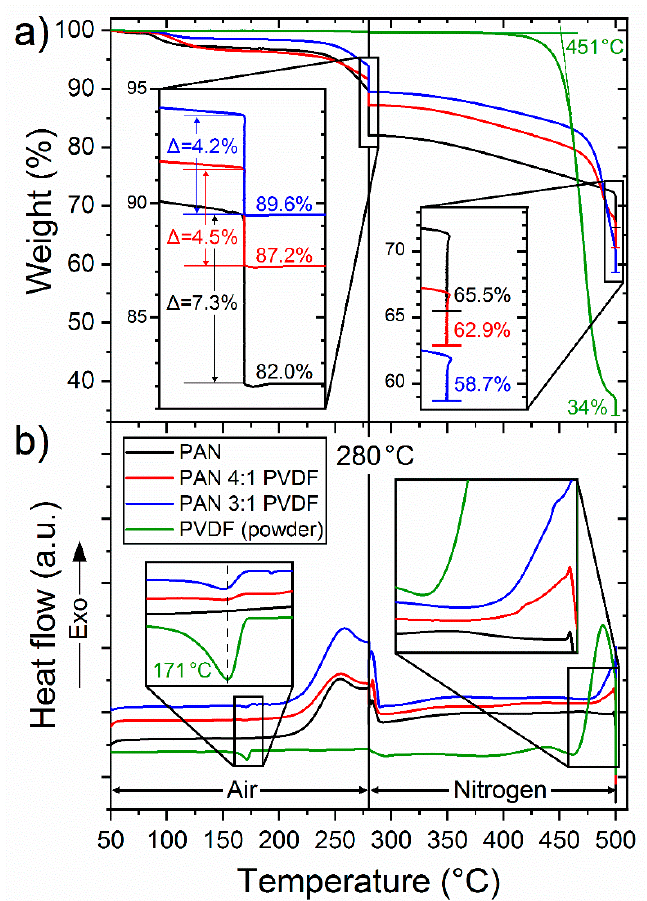
Figure 4. Results of ( a ) TGA and ( b ) DSC measurements of all examined nanofiber nonwovens according to the described stabilization and carbonization routes. The discontinuities in the curves indicate 1 h isothermal phases. Note that the highlighted numbers show remaining mass values.